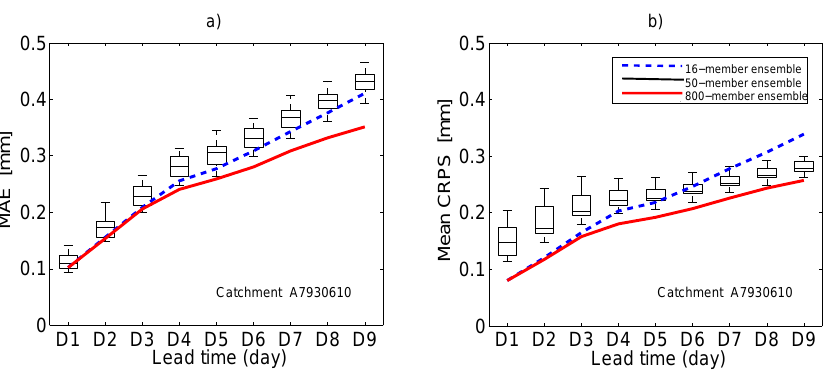
Fig. 3. Example of MAE and CRPS values for a given catchment (A793061: Moselle River at Hauconcourt; area=9387km 2 ) and three types of ensemble predictions.